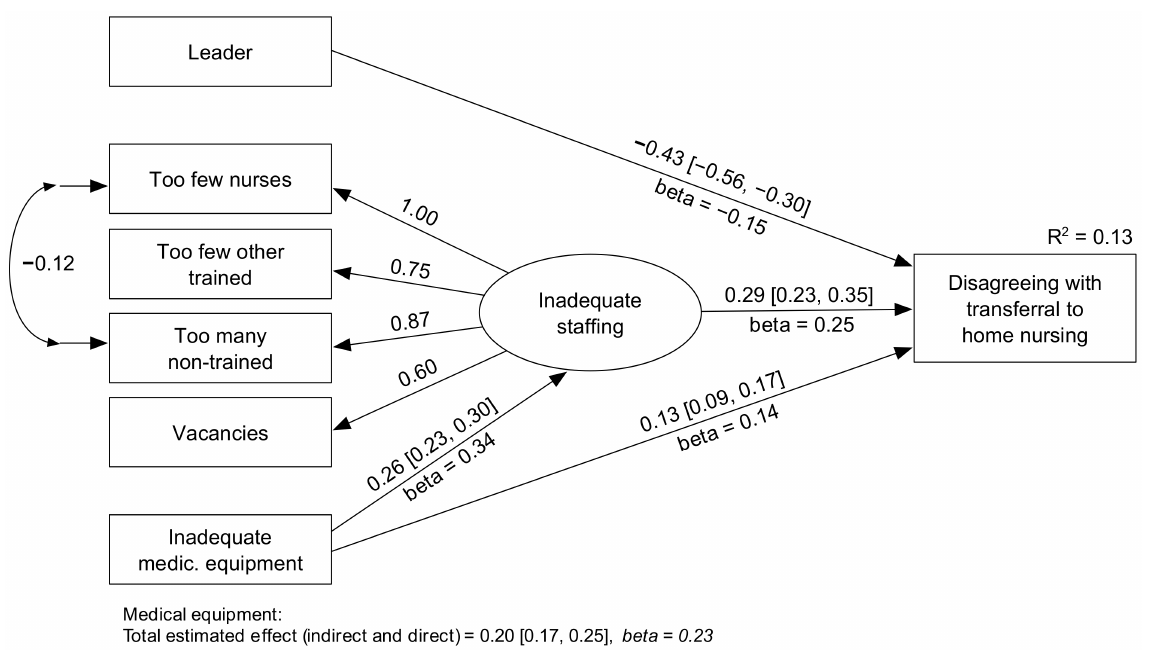
Figure 2. Home nurses disagreeing with transferrals to home nursing. Fully standardized esti- mates are labeled beta: the remaining numbers are unstandardized estimates (some with 95% con- fidence interval). Estimated total effect for the variable “Inadequate medical equipment” was b = 0.21 (95% CI = 0.17, 0.25), beta = 23. All parameters had p < 0.001. The model had sufficient fit: scaled chi-square (11) = 63.653, p < 0.001, scaled comparative fit index = 0.982, scaled root mean square error or approximation = 0.049, with a 90% confidence interval from 0.038 to